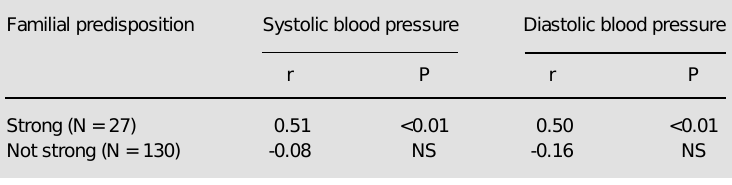
Figure 1 - Influence of familial